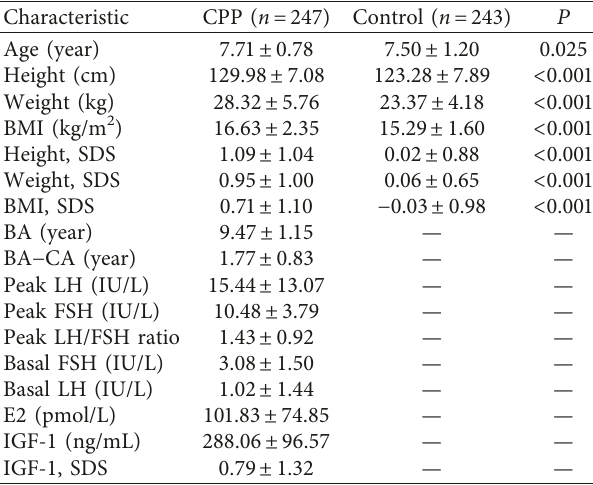
Table 1: Clinical characteristics and results of hormone assays in the study